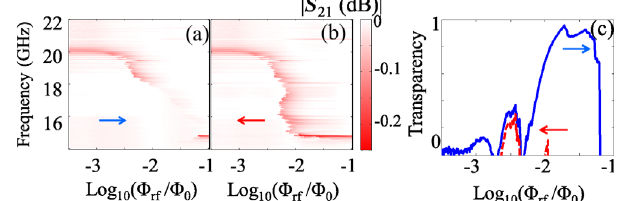
FIG. 2. Measured transmission as a function of frequency and applied rf flux for an 11 × 11 array rf SQUID metamaterial, when the input rf flux (a) keeps increasing and (b) continuously decreases. (c) Extracted transparency values for sweep directions (a) and (b). The arrows denote the rf flux scanning directions. The temperature is 4.6 K.